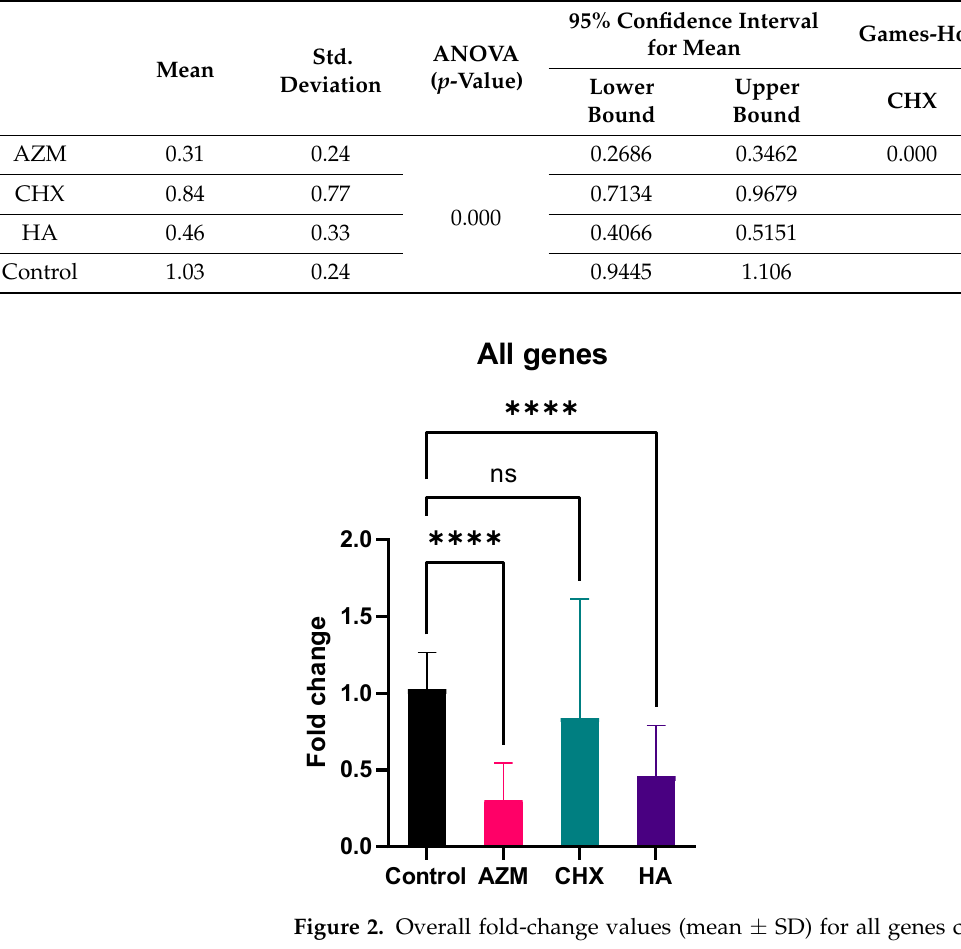
Table 2. Overall fold-change values for all genes combined.